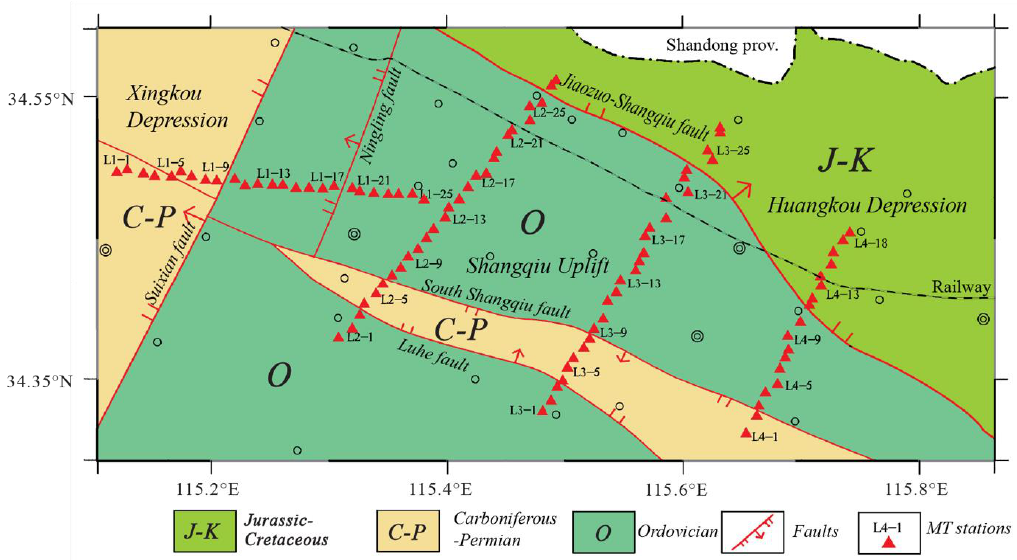
Figure 2. The distribution map of the MT stations in the study area with strata and structural infor-